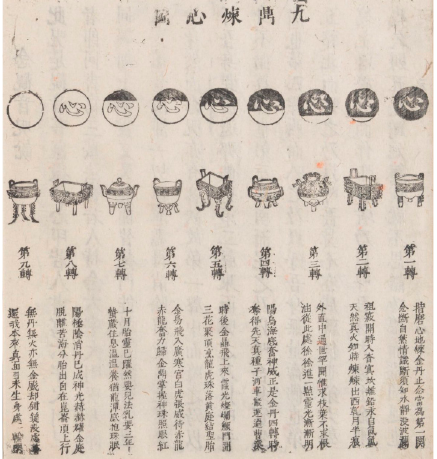
Figure 14. Diagram of refining the heart by the nine tripods (Wu 1615,